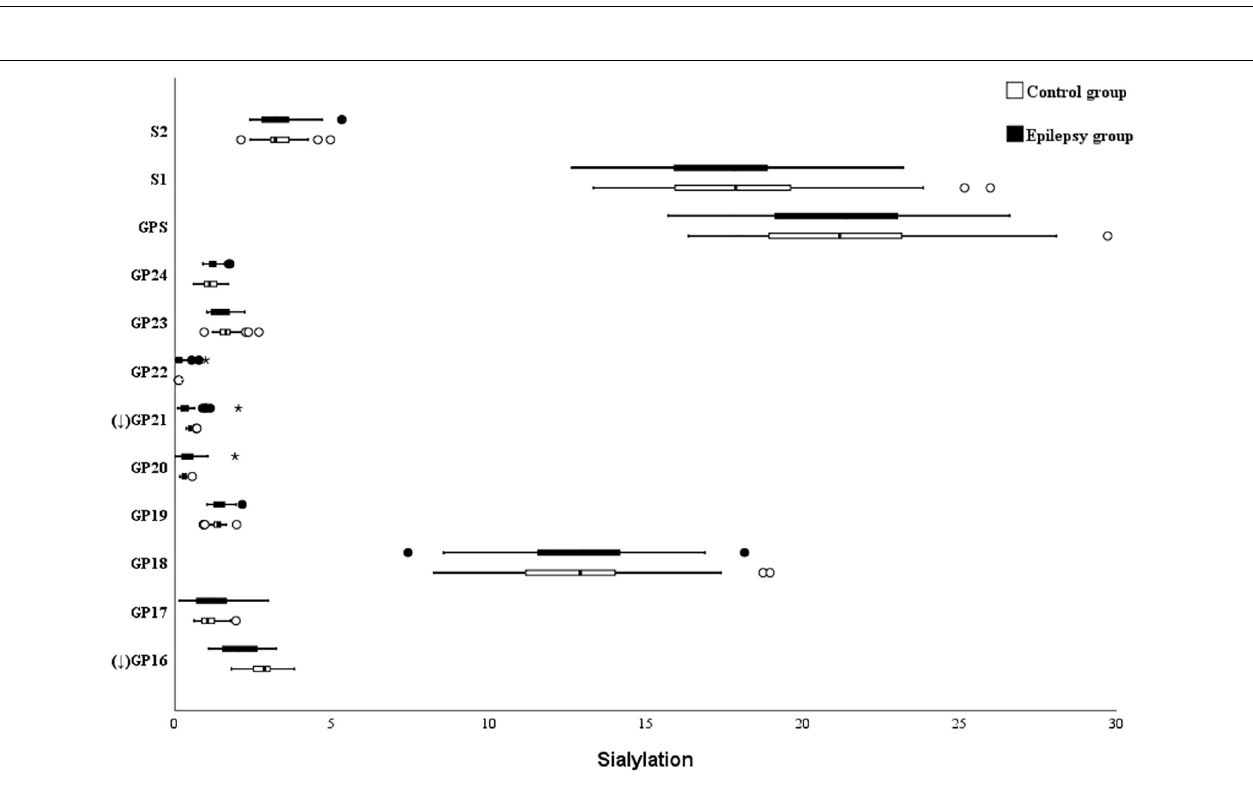
FIGURE 3 | Sialylation on Ig G in Epilepsy patients and the healthy controls. GP, glycan peak; S, Sialic acid; G, galactose; ↑ the glycan in Epilepsy group in significantly higher than that in the controls; and ↓ the glycan in Epilepsy group in significantly lower than that in the controls. *Represents the extreme values in the sample